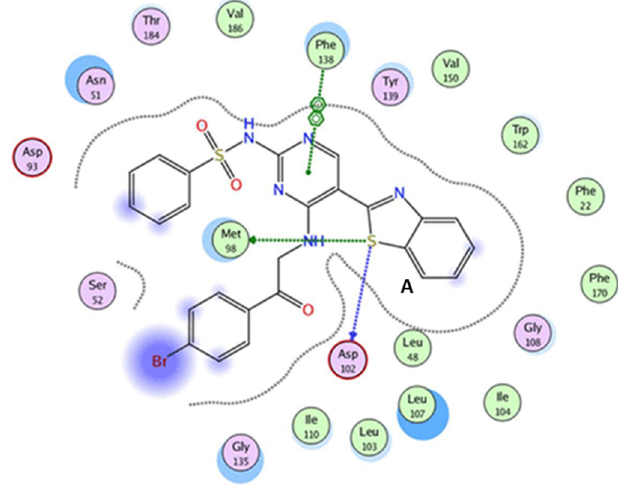
Figure 8. Best docked position of A within the binding pocket of Hsp90 (PDB ID 3b25).